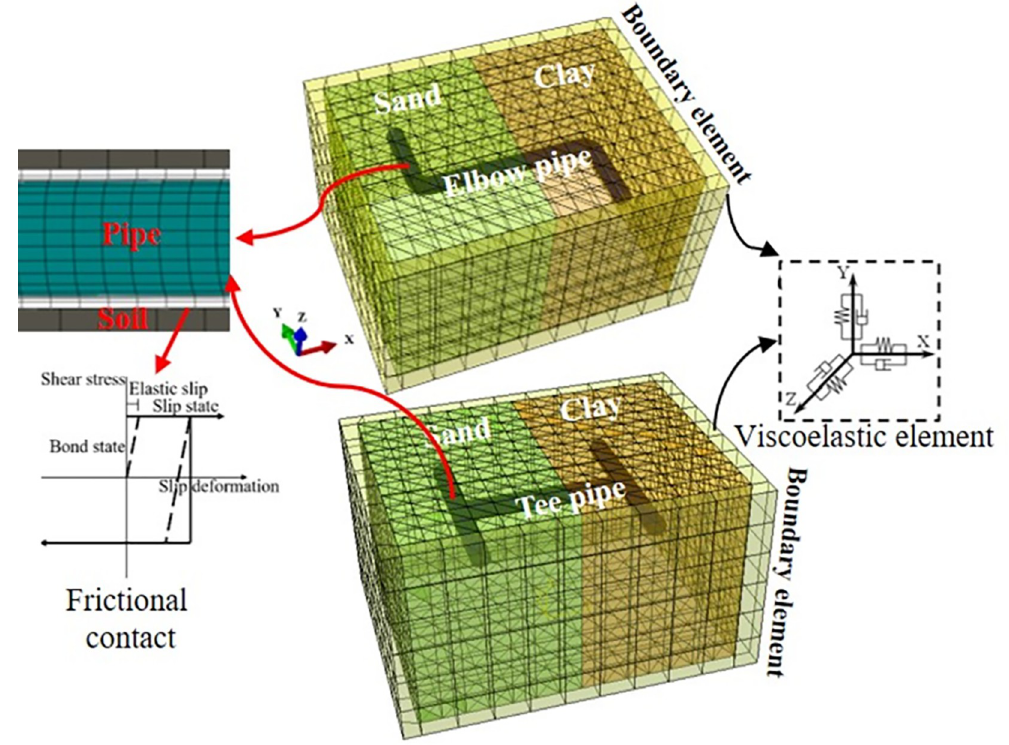
Fig 3. Finite element models of the pipes.